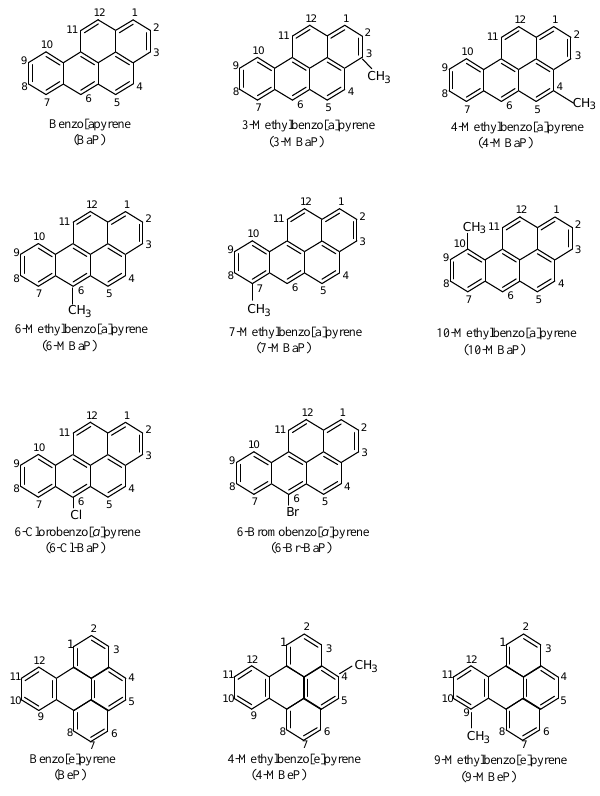
Figure 1: Structures of benzo[a]pyrene (BaP), methylated benzo[a]pyrene (MBaP), benzo[e]pyrene (BeP),